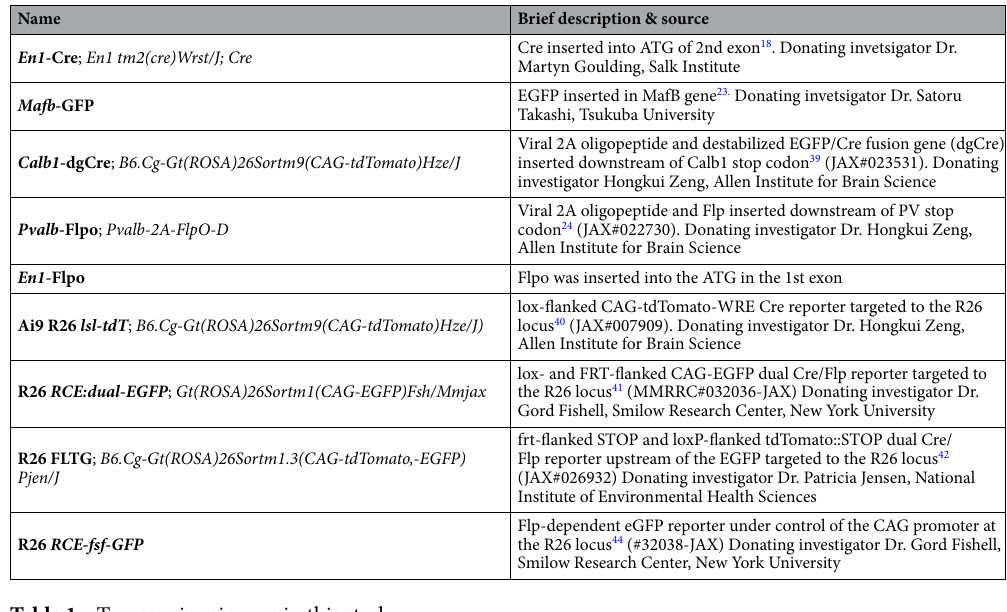
Table 1. Transgenic mice use in this